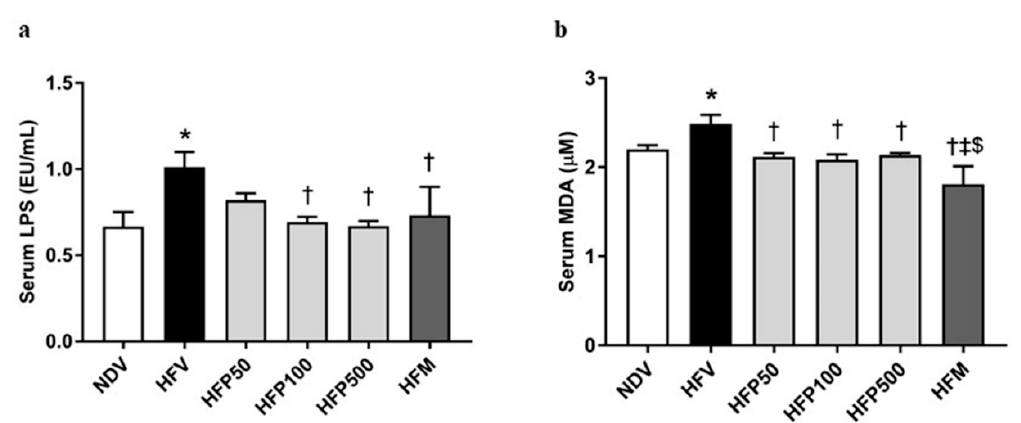
Figure 5. The effect of PSO on endotoxemia and oxidative stress in obesity-induced insulin-resistant rats. ( a ) Serum LPS level. ( b ) Serum MDA level. Data are presented as mean ± SEM, * p < 0.05 versus the NDV group; † p < 0.05 versus the HFV group ; ‡ p < 0 . 05 versus HFP50; $ p < 0 . 05 versus HFP500.